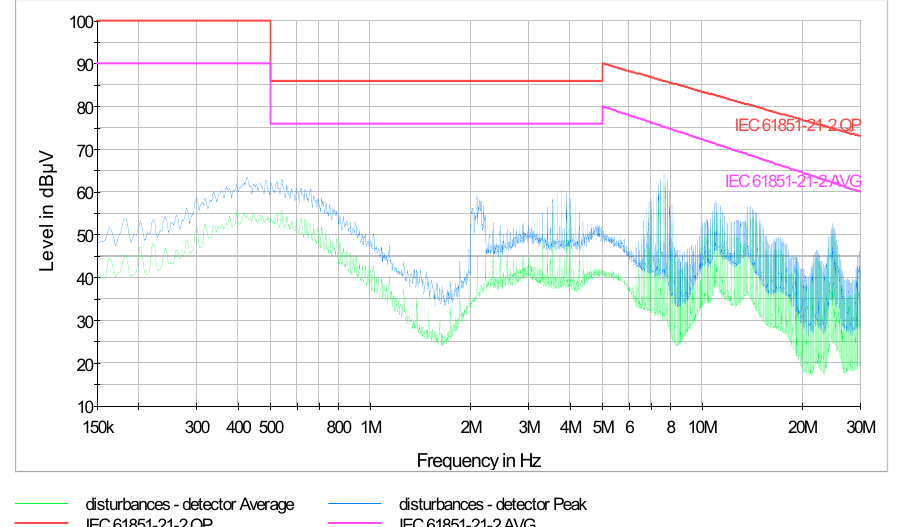
Figure 11. Conductive disturbances of the charging station, DC module operation (20% power), IEC 61851-21-2 limits for average and quasipeak detectors; blue line—disturbance level measured by the peak detector, green line—disturbance level measured by the averaging detector.